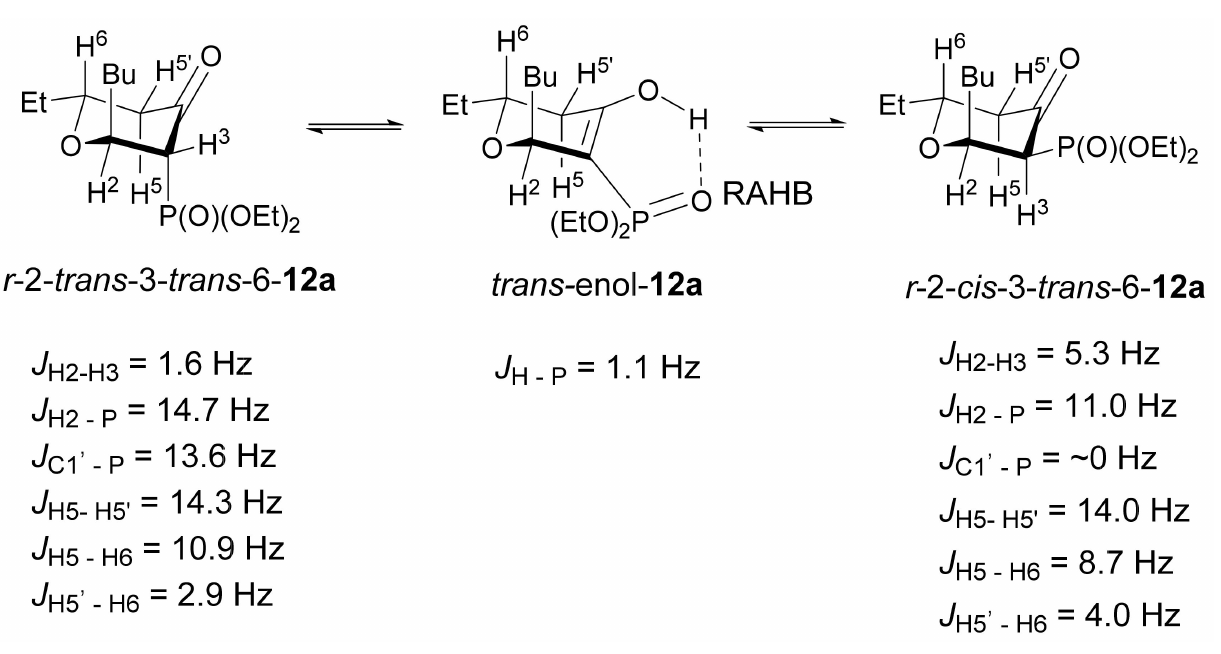
Figure 2. Characteristic coupling constants of all isomers of 2- n -butyl-6-ethyl-3- diethoxyphosphoryltetrahydropyran-4-one 12a